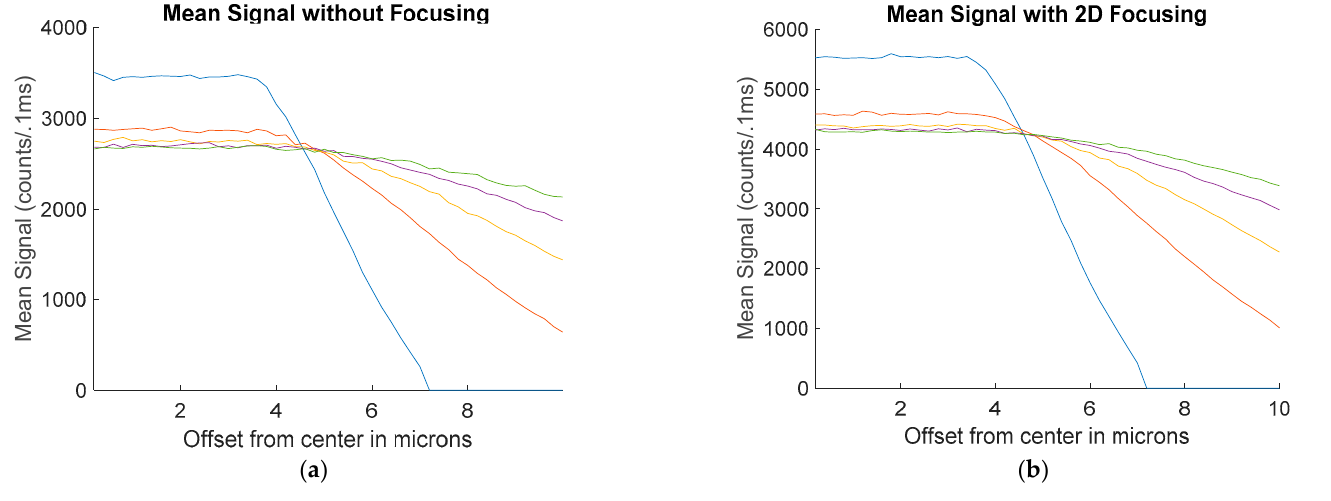
Figure 12. The mean signal as a function of alignment offset for 4-, 6-, 8-, 10-, and 12-micron spot sizes with: ( a ) no focusing; ( b ) 2D hydrodynamic focusing.